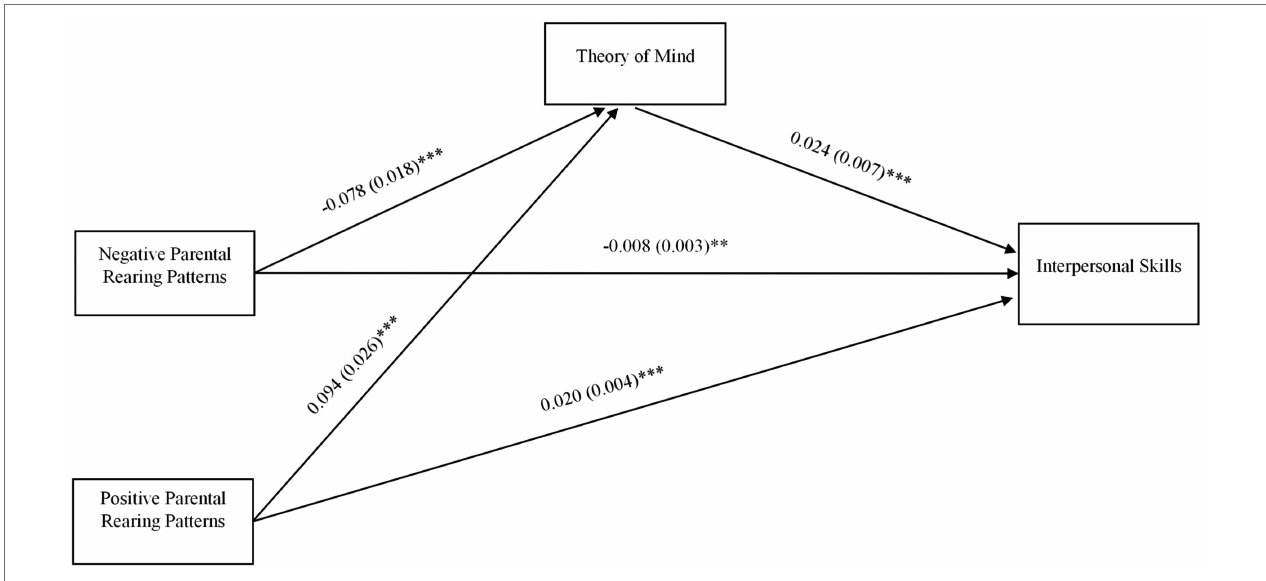
FIGURE 1 | Indirect effects of parental rearing patterns on interpersonal skills via Theory of Mind (ToM). Path coefficients (b and standard error, SE) are unstandardized. Model controlled for potential effects of gender and age on ToM and interpersonal skills. *** p < 0.001; ** p < 0.01; * p <